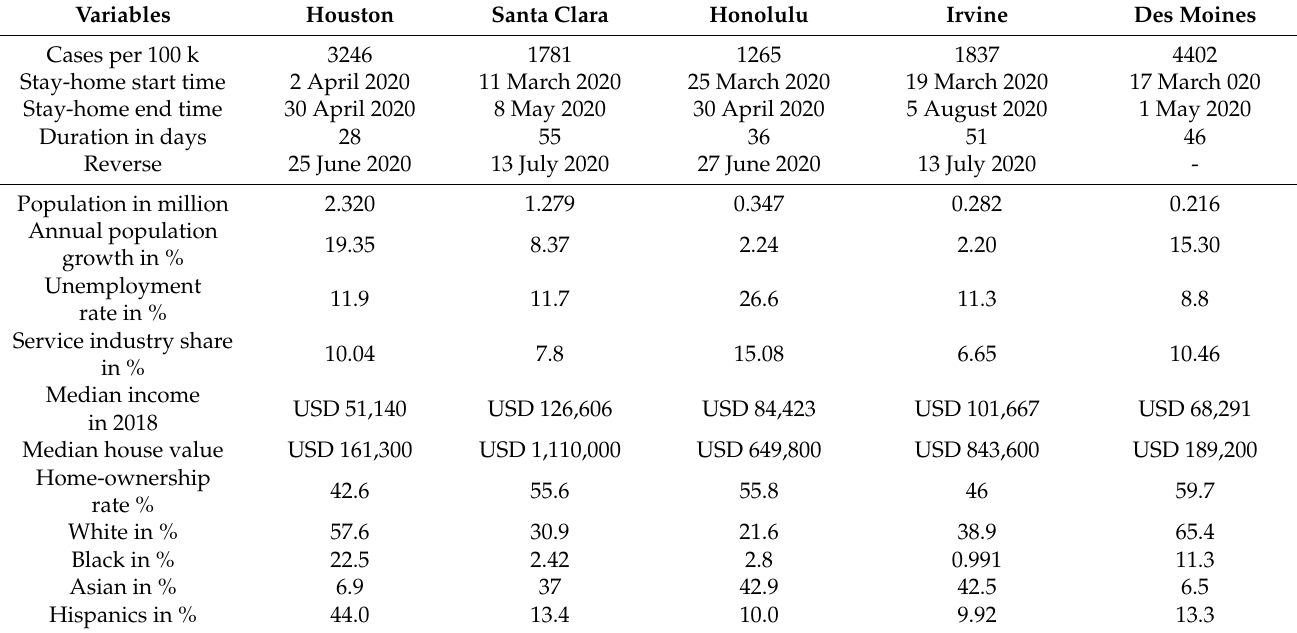
Table 1. Summary statistics of COVID-19 and economic